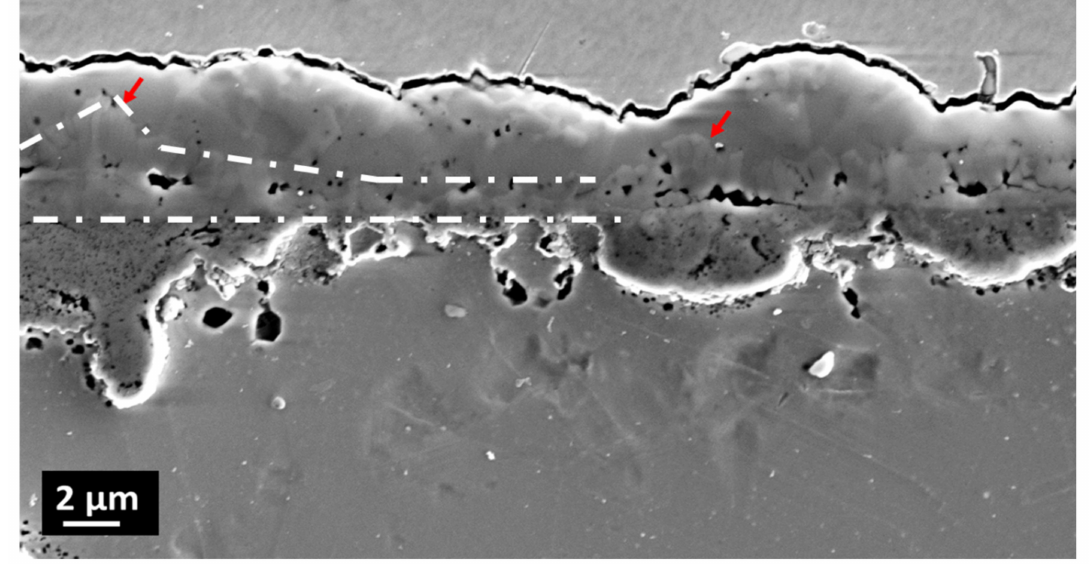
Figure 3. Cross section through oxide scale of the sample oxidized at 700 ◦ C for 500 h in steam. The arrows indicate columnar crystals.